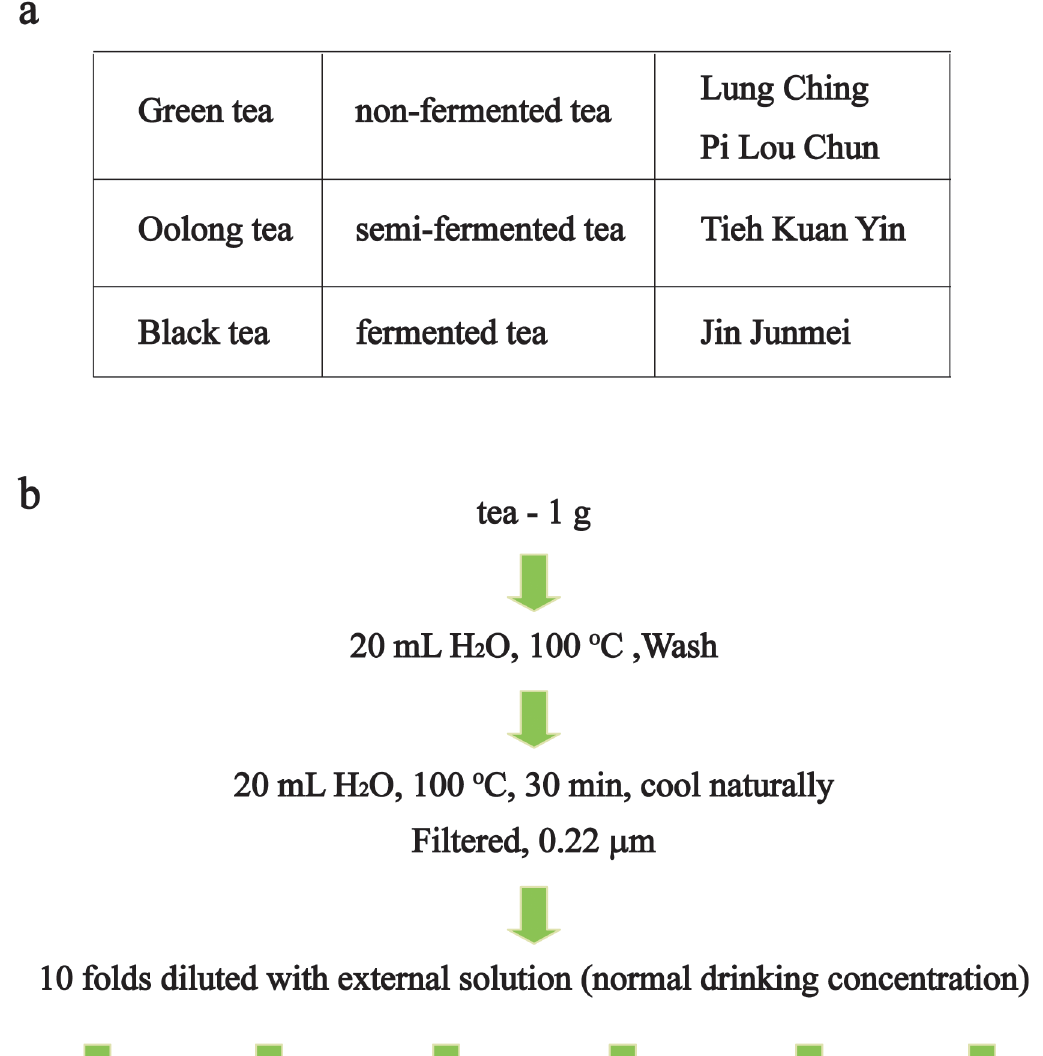
Fig 1. The classification (a) and preparation of teas